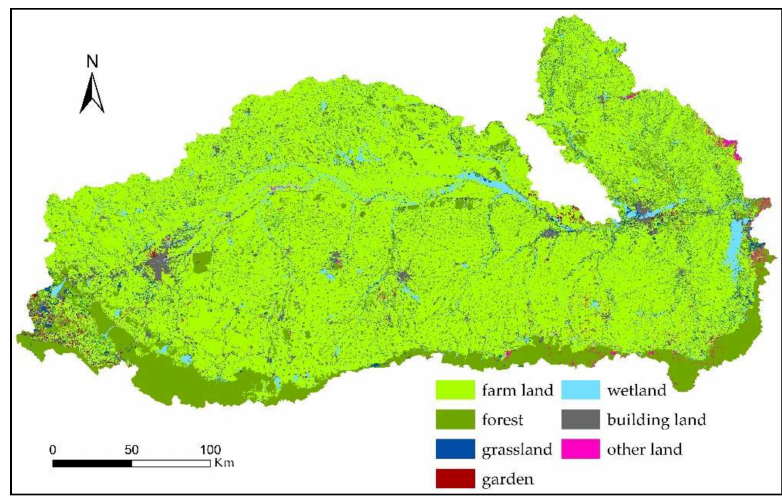
Figure 10. Landuse map of the Mun River